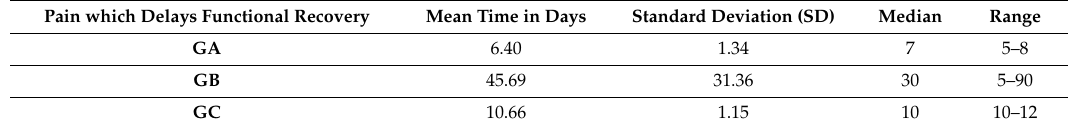
Table 3. Time to functional recovery (days) in patients with